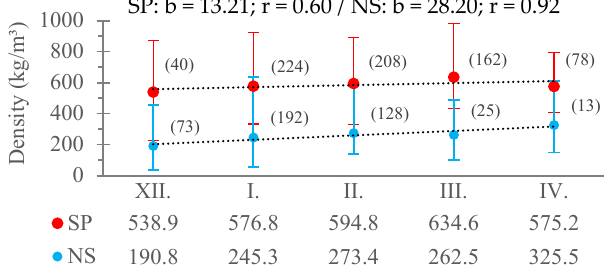
Figure 4. ( a ) Comparison of the data for three seasons with regard to the snow density of new natural snow (NN), new artificial snow (NA), uncompacted natural snow (NS), and ski piste snow (SP) for the five ski centers. The lowest number of measured samples (N = 30) was in the case of NA in Kra í liky and NN in Krahule. Description of boxplot: cross = mean, horizontal line in the box = median, box = 50% of values, box with whiskers = 99% of values, points = outliers. ( b ) Boxplots of the minimal, maximal, and mean density identified in each of five ski centers (excluding outliers) over the three winter seasons for four snow types ( n = 5).